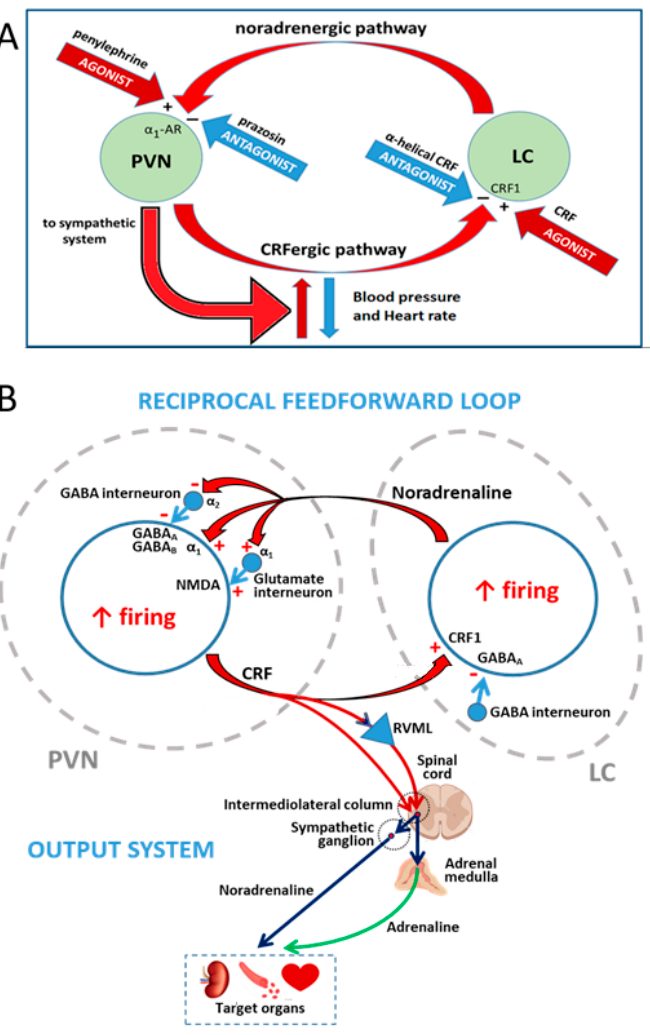
Figure 7. Summary of the working hypothesis, results and discussion. ( A ) Reciprocal excitatory interactions between the paraventricular nucleus of the hypothalamus (PVN) and the locus coeruleus (LC) led to hypertension and tachycardia in prenatally undernourished adult rats, increasing the outflow from the PVN to the sympathetic system. The closed loop works at a high activity level in prenatally undernourished adult rats and could be inhibited by the antagonists ( − ) prazosin (PVN) or α -helical CRF (LC), rescuing the animals from hypertension and tachycardia but it could not be overactivated by the agonists (+) phenylephrine (PVN) or CRF (LC). In eutrophic animals the loop works at a lower activity level that could not be inhibited by prazosin (PVN) or α -helical CRF (LC) but activated by phenylephrine (PVN) or CRF (LC), inducing hypertension and tachycardia. Activation of the loop (red arrows) led to hypertension and tachycardia in eutrophic animals, while interruption of the loop (blue arrows) led to normal blood pressure and heart rate in prenatally undernourished adult rats. ( B ) A more detailed view of the PVN-LC loop, taking into account the role of interneurons in the neural network of the PVN and the LC as supported by the literature: α 1 and α 2 receptors for noradrenaline, GABA A and GABA B receptors for γ -aminobutiric acid, NMDA receptor for glutamate, and CRF1 receptor for CRF are indicated in a CRF-expressing neuron within the PVN and a noradrenaline-synthesizing neuron within the LC; plus sign (+) and minus ( − ) sign represent receptor-mediated excitation or inhibition, respectively. The PVN output to target organs mediating hypertension and tachycardia via the sympathetic system is depicted; RVLM, rostral ventrolateral medulla.